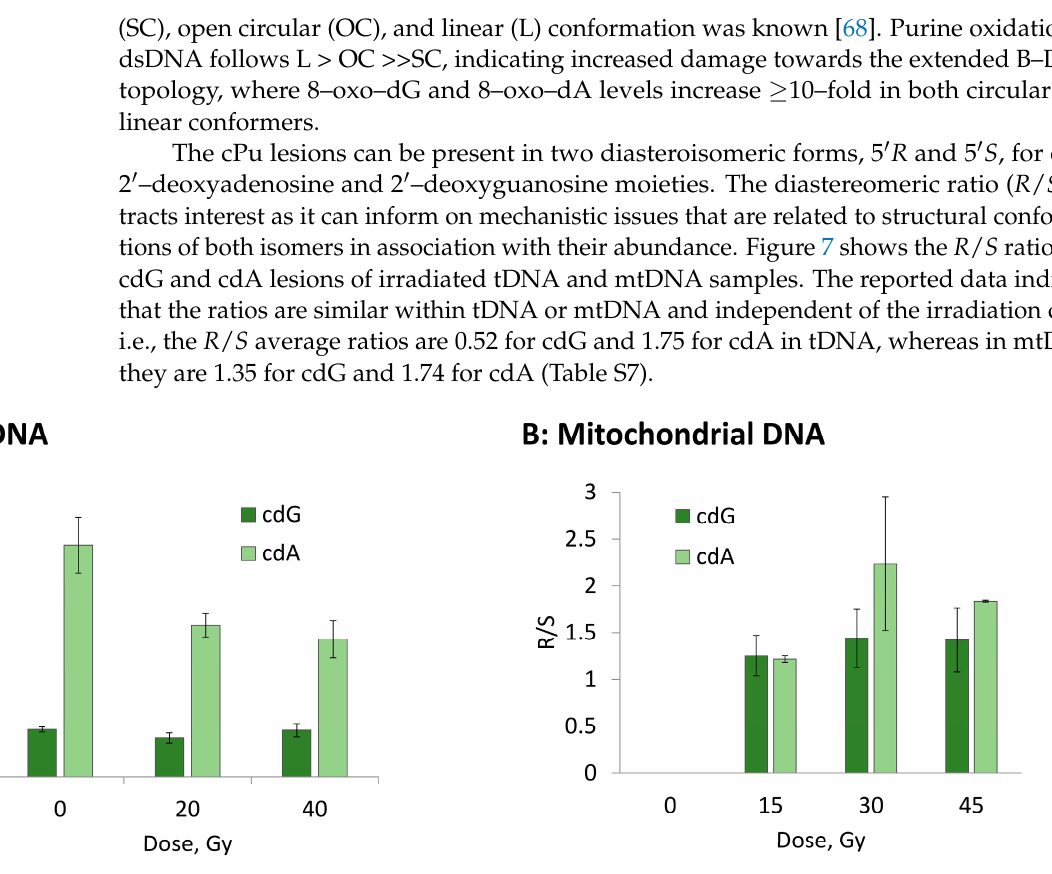
Figure 7. Diastereoisomeric ratios (5 ′ R /5 ′ S ) for cdG and cdA lesions in irradiated samples of tDNA ( A ) and mtDNA ( B ). The numbers represent the mean value ( ± standard deviation) in triplicate.